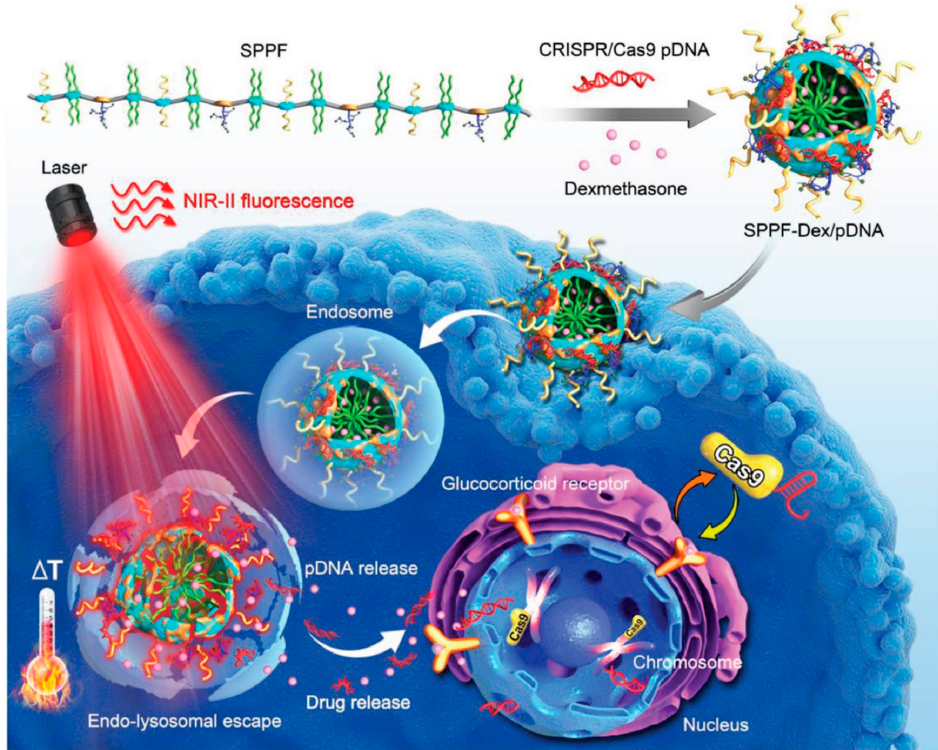
Figure 11. Gene delivery based on CRISPR/Cas systems. The therapeutic efficacy and mechanism of the nanoparticle in HCT 116-GFP tumor models. Reprinted with permission from Ref. [127]. Copyright 2019, Chen, X.